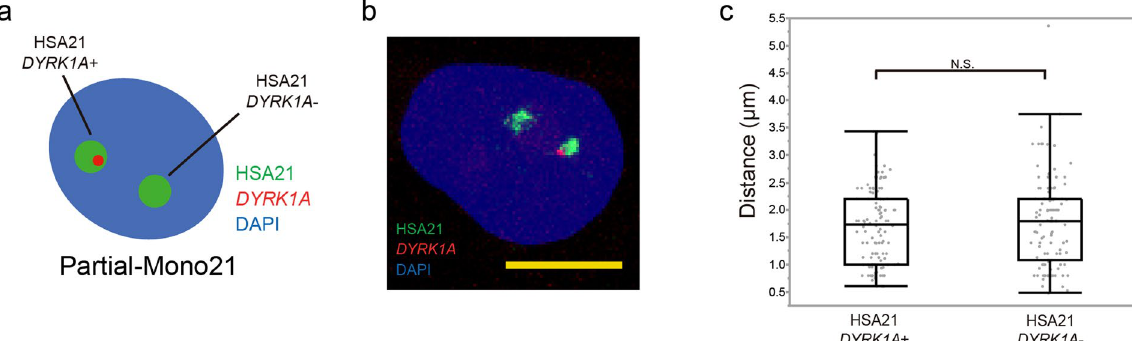
Figure 4. Chromosome positioning of chromosome 21 in Partial-Mono21 iPSCs. ( a ) A schematic of 3D-FISH analysis in Partial-Mono21 iPSCs. Two copies of chromosome 21 (green) can be distinguished each other by co-labelling with a DYRK1A probe (red). ( b ) Representative 3D-FISH images of Partial-Mono21 iPSCs. Chromosome 21 was labelled with Alexa488 (green), while the DYRK1A gene was labelled with Cy3 (red). Nuclei were stained with DAPI. Scale bars represent 10 μ m. ( c ) The distance from chromosome 21 to the nearest nuclear membrane in Partial-Mono21 iPSCs (n = 120). Box plot represents 25th–75th percentile range ± min– max. p values were determined by the Mann–Whitney U test. * p < 0.05, ** p <